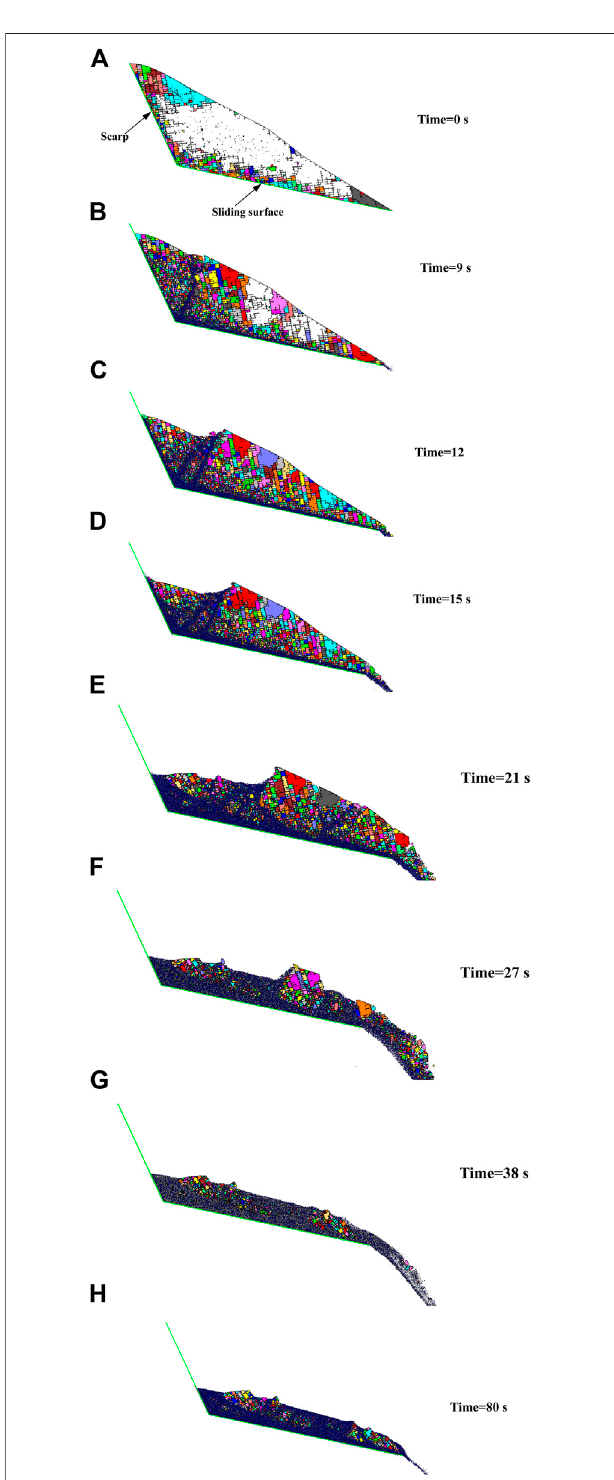
FIGURE 9 | Progressive fragmentation of the upper sliding mass during